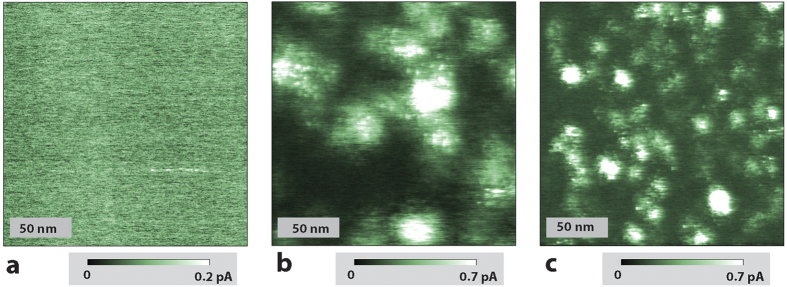
Conduction AFM images of c-Si samples with different P surface and bulk concentrations prepared by ion implantation.The tip-bias voltage applied for each measurement is (a) 1.1 V, (b) 1.3 V and (c) 1.2 V. (a) [P] = 5 × 1014 cm−3. No recognizable current maxima with significance above the noise level are observed. (b) [P] = 3 × 1017 cm−3. Current maxima with areal density of about ~4 × 1010 patches/cm−2 are observed. (c) [P] = 5 × 1018 cm−3. Current maxima with a high areal density ~2 × 1011 patches/cm−2 are observed. The observed densities of the patches fluctuate within a 12% range for different locations of the same sample, consistent with stochastic fluctuations expected from the given samples sizes. Note that the maximum current of ∼1pA in (b) and ∼5pA in (c) exceed the displayed current range. The current range was chosen in order to provide optimal contrast.